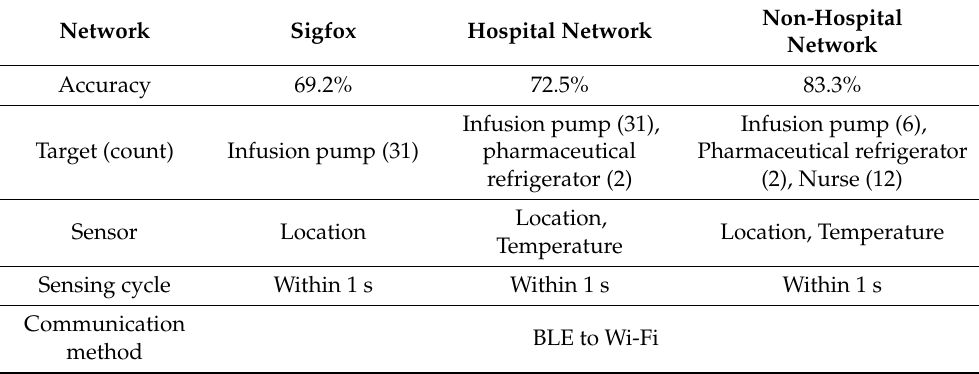
Table 10. Summary of Results According to the Network